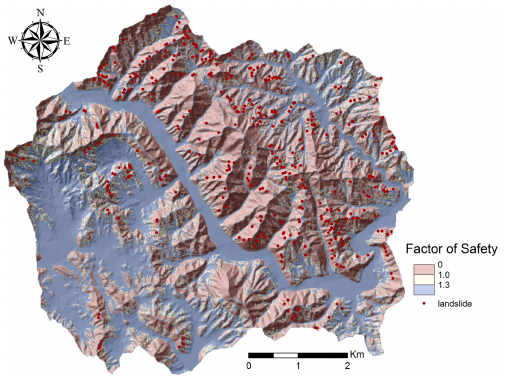
Figure 14. Map showing the factor of safety predicted using the steady-state hydrological